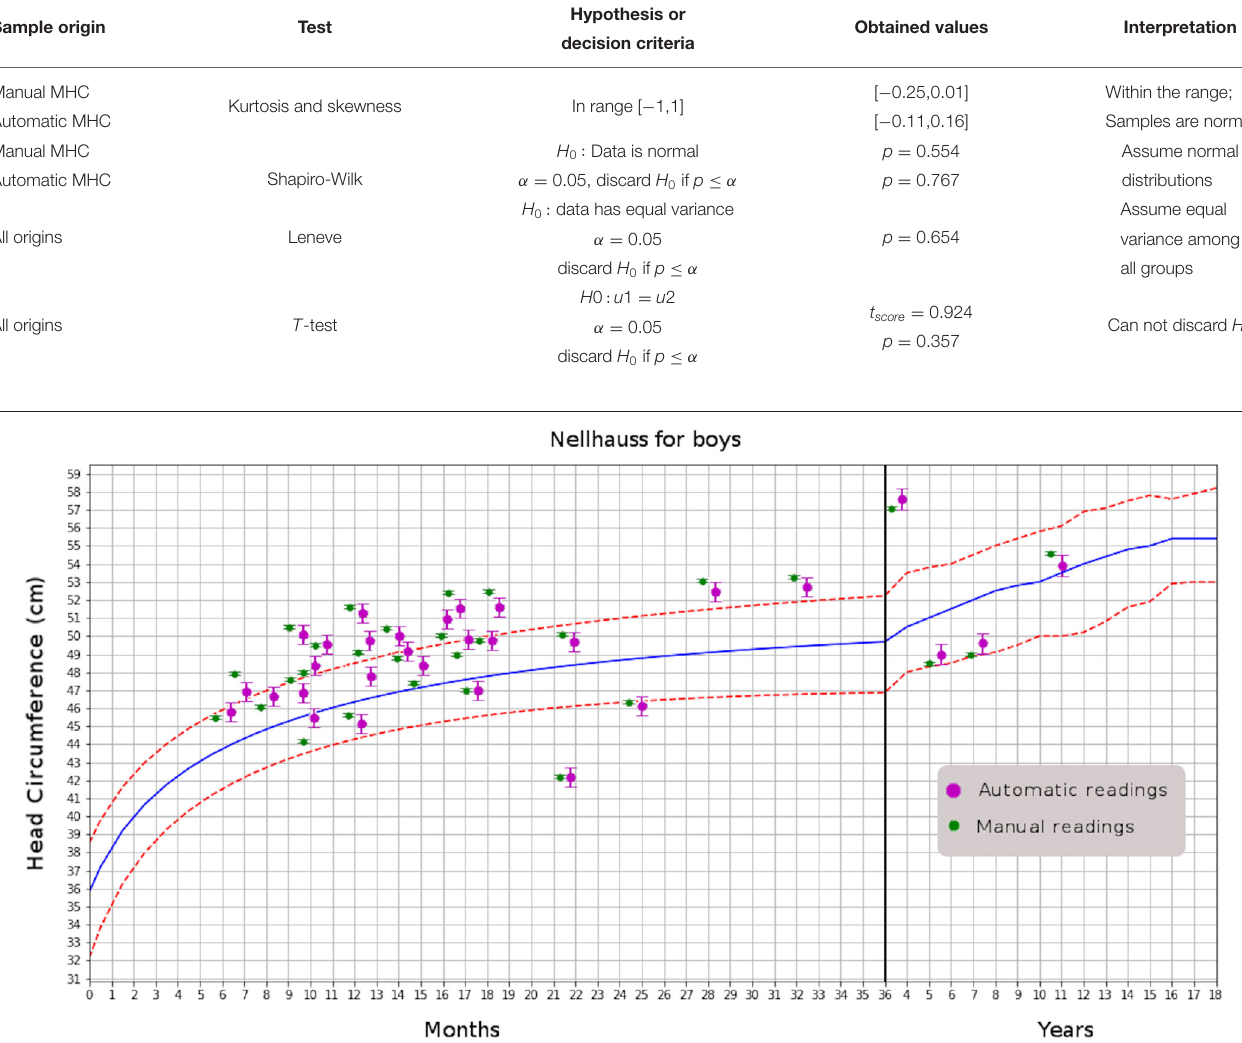
for Disease Control and Prevention (CDC) (28).